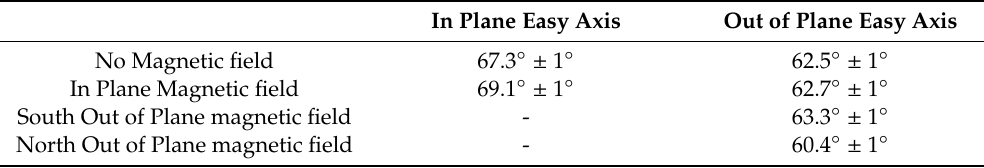
Table 1. Tilt angle analysis of SAMs with respect to the sample normal measured just after adsorption. This table shows the tilt angles of the SAM for both areas with IP easy axis and OoP easy axis and for both cases with an applied external field and without it. It is clear that the tilt angle is correlated with the easy axis direction of the FM layer, even when an external magnetic field is applied.